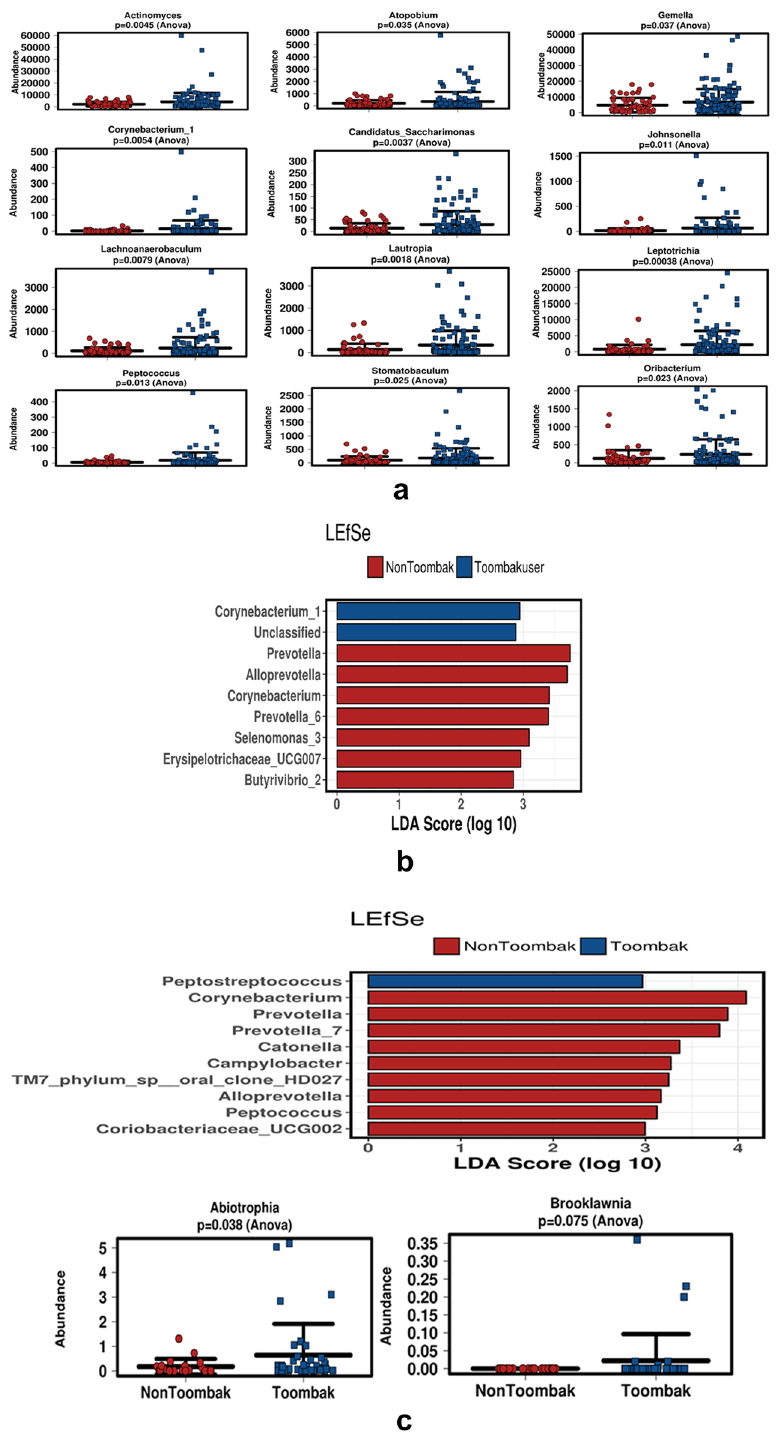
Figure 5. ( a ) The most abundant genera with p -value significance amongst Toombak users (blue) and non-users (red). One way Anova variations between significant genera in Toombak use and non-Toombak use. Actinomyces ( p = 0.0045), Corynebacterium_1 ( p = 0.0054), Lachnoanerobaculum ( p = 0.0079), Lautropia ( p = 0.0018), Atopobium ( p = 0.035), Gemella ( p = 0.037), Johnsonella ( p = 0.011), Leptotrichia ( p = 0.00038), Candidatus_Saccharimonas ( p = 0.0037), Peptococcus ( p = 0.013), Ruminococcaceae_UCG014 ( p = 0.0052) as well as Oribacterium ( p = 0.023) and uncultured bacterium ( p = 0.025) were more abundant in Toombak users. ( b ) LEfSe plotting on pooled saliva dataset. LEfSe plotting on pooled saliva dataset indicated that Corynebacterium_1 and unclassified bacterium were discriminant for Toombak use while Prevotella, Selenomonas , Erysipelotrichaceae and Butyrivibrio_2 were discriminant for non-users. ( c ) Supragingival microbiome in the Sudanese population and the relative abundances of significant genera in plaque. LEfSe plotting showed that Peptostreptococcus was the most distinct genus amongst Toombak users while Corynebacterium, Prevotella and Catonella were the most distinguishing genera in non-users plaque samples. Abiotrophia ( p = 0.038) and Brooklawnia ( p = 0.075) were on the other hand significantly abundant in the plaque of Toombak